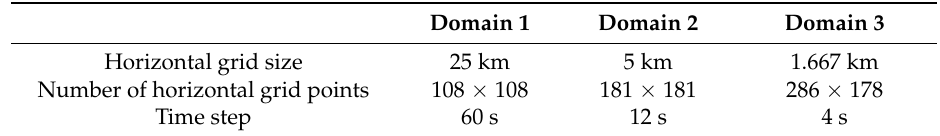
Table 2. Horizontal grid size, number of horizontal grid points, and time step in each computational